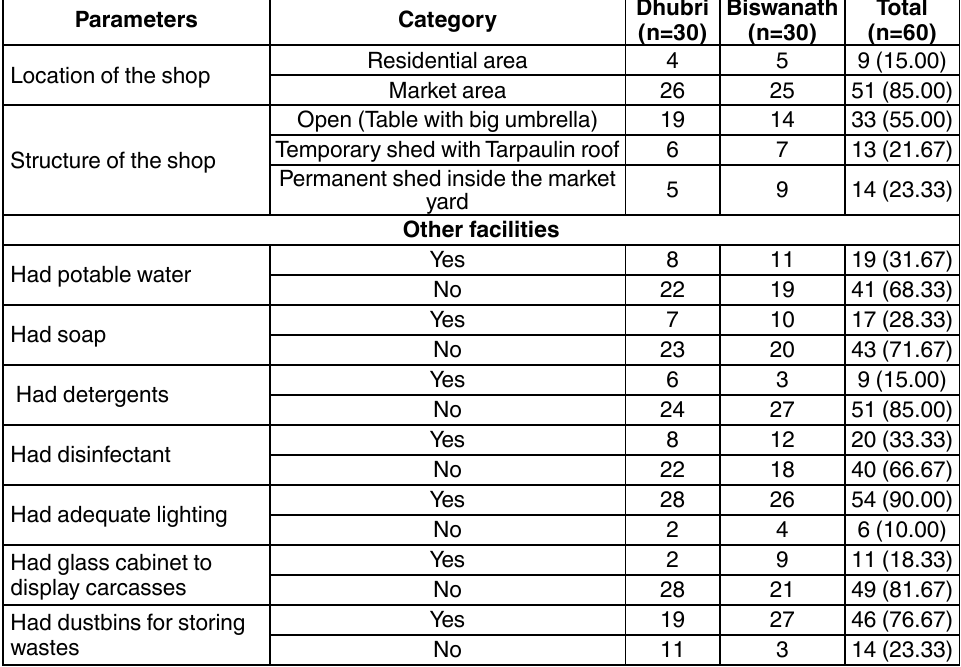
table 2. Distribution of respondents based on location and structure of the poultry meat shop